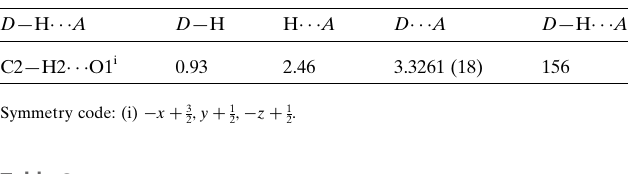
Table 1 Hydrogen-bond geometry (A˚ , (cid:2) ).